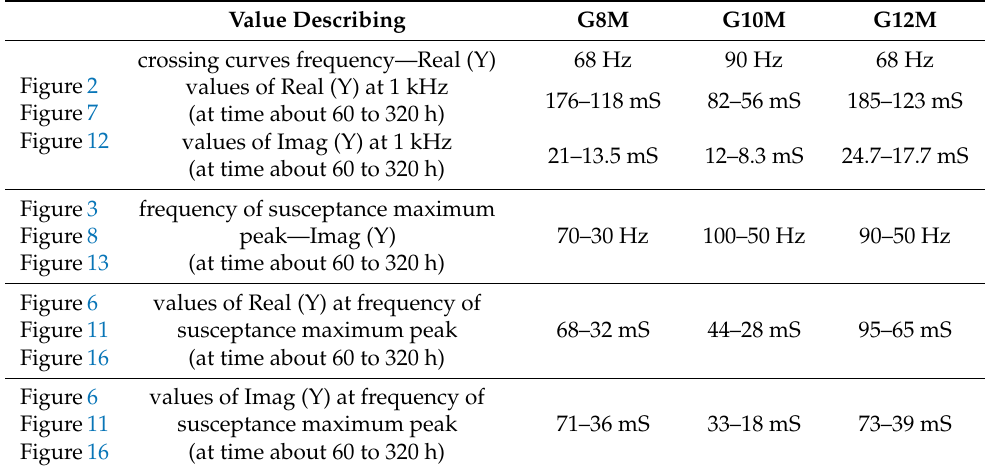
Table 5. Characteristics of geopolymer values obtained from listed figures—usable for comparison.